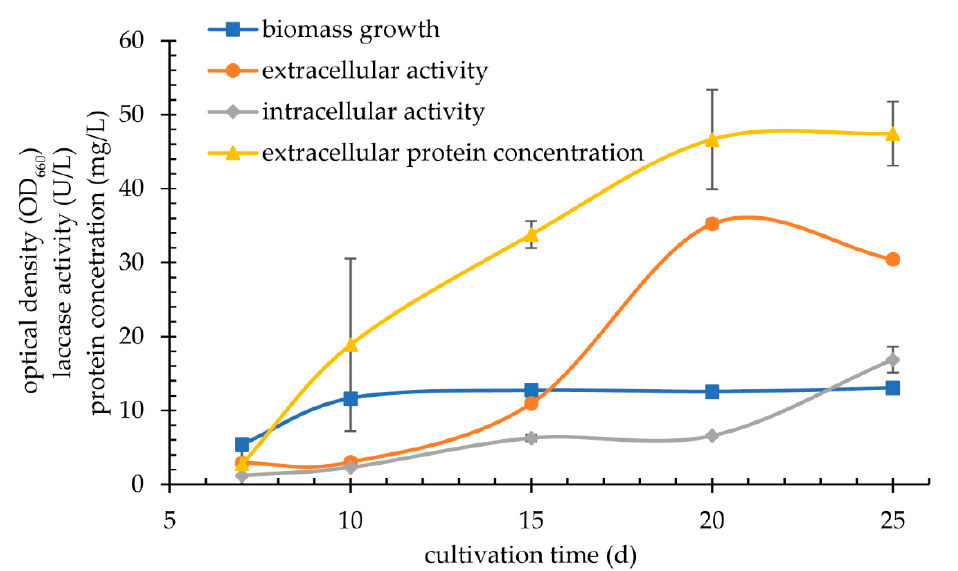
Figure 3. Growth, protein content, extracellular and intracellular laccase activity in the culture of strain G3 IBMiP in the Sivakumar medium.